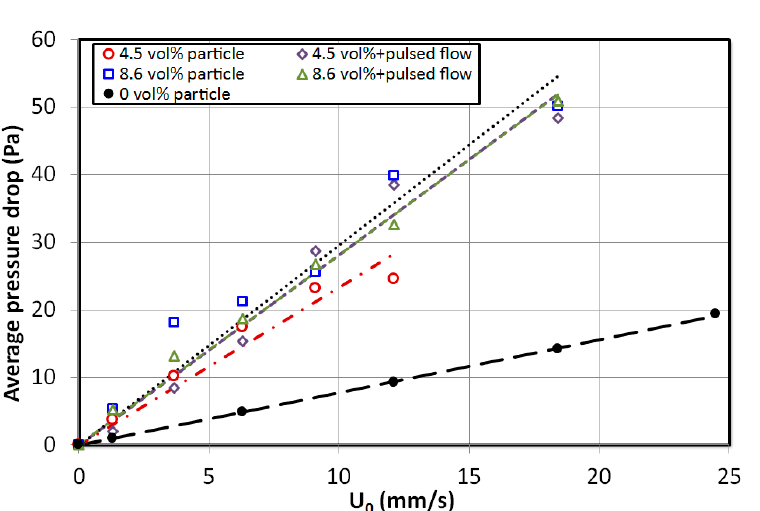
Figure 6. Nanoparticle agglomerate diameter calculation by equation fitting on average pressure drop results. drop Table 2. Agglomerate size reduction under different fluidization conditions (external particle diameter: 56.5 µm).